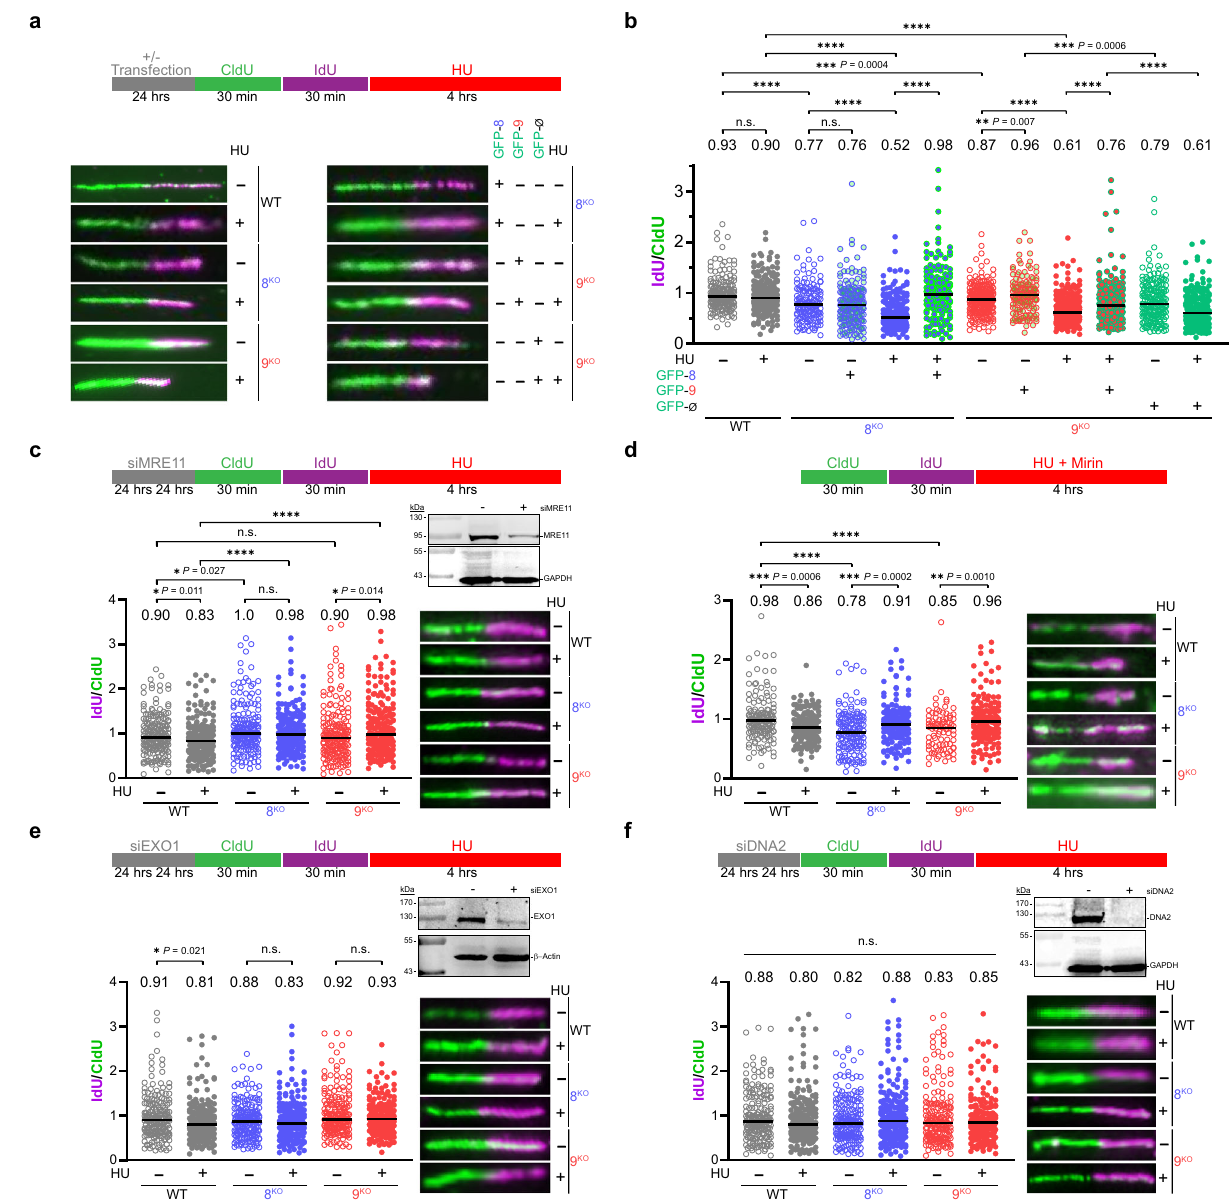
Fig. 4 | Replicationforksare unstable inthe absence ofMCM8/9and degraded byacombinationofnucleases.a CellswerelabeledwithCldUfollowedbyIdUfor the indicated time intervals followed by 2mM HU for 4h. Experiments containing plasmids for GFP-MCM8, GFP-MCM9, or GFP alone (Ø) were transfected for 48h prior. DNA was spread by gravity to measure NSD and representative fi bers are shown. b IdUandCldUlengthsfor293TWT(gray),8 KO (blue),or9 KO (red)cellswere measuredusingImageJandthecorrespondingmedianratiosreportedatthetopof the plots and by a black line embedded in the data. Open circles ( ○ ) represent